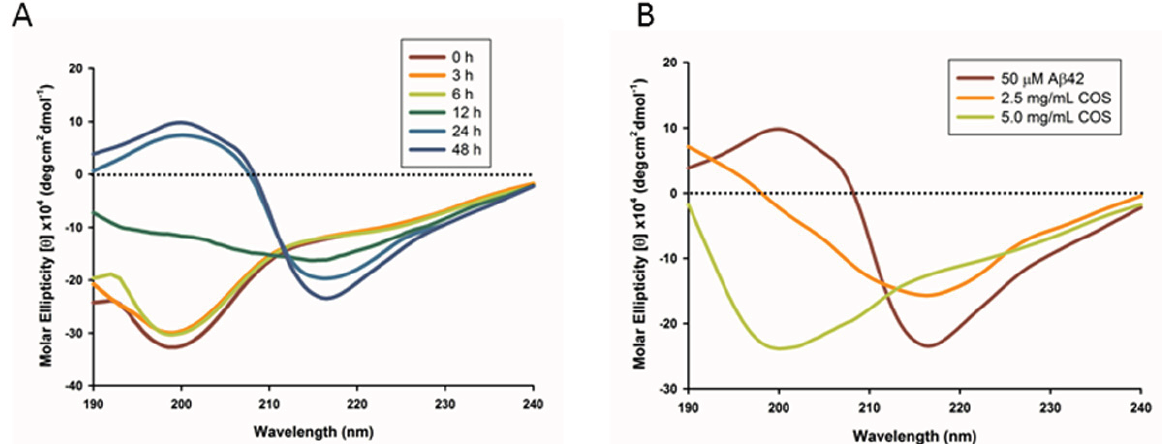
Figure 1. Circular Dichroism (CD) spectroscopy of A β 42. Amyloid- β (A β ) peptides were diluted with 10 mM phosphate buffer to a final concentration of 50 μ M in each sample. ( A ) CD spectra of A β 42 upon incubation were recorded in the UV region (190–240 nm) at 0, 3, 6, 12, 24 and 48 h respectively; ( B ) CD spectra of 50 μ M A β 42 were recorded in the UV region (190–240 nm) upon coincubation with 2.5 or 5.0 mg/mL chitosan oligosaccharides (COS) (when present) respectively for 48 h. Data were the average of six runs and represented as rainbow color curves after being